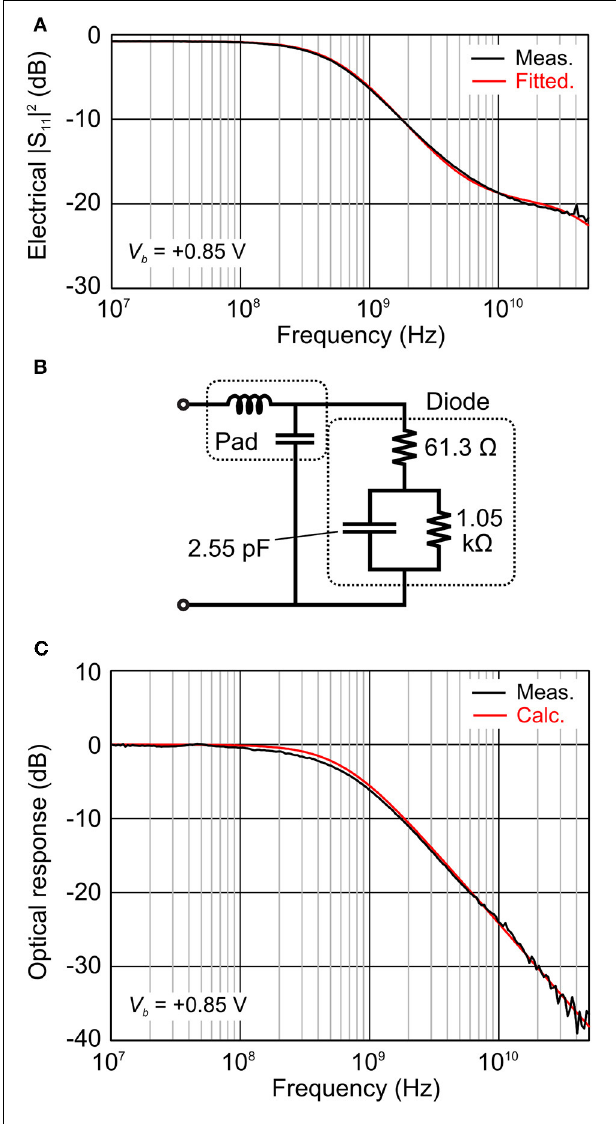
FIGURE 6 | (A) Measured electrical S 11 parameter (black) of 60- µ m long phase shifter with fitted curve (red) by using extracted equivalent circuit shown in (B) . (C) Measured (black) and calculated (red) optical frequency response of MZ modulator. Optical response was calculated as dependencies of amount of stored charge in diode capacitance on frequency.